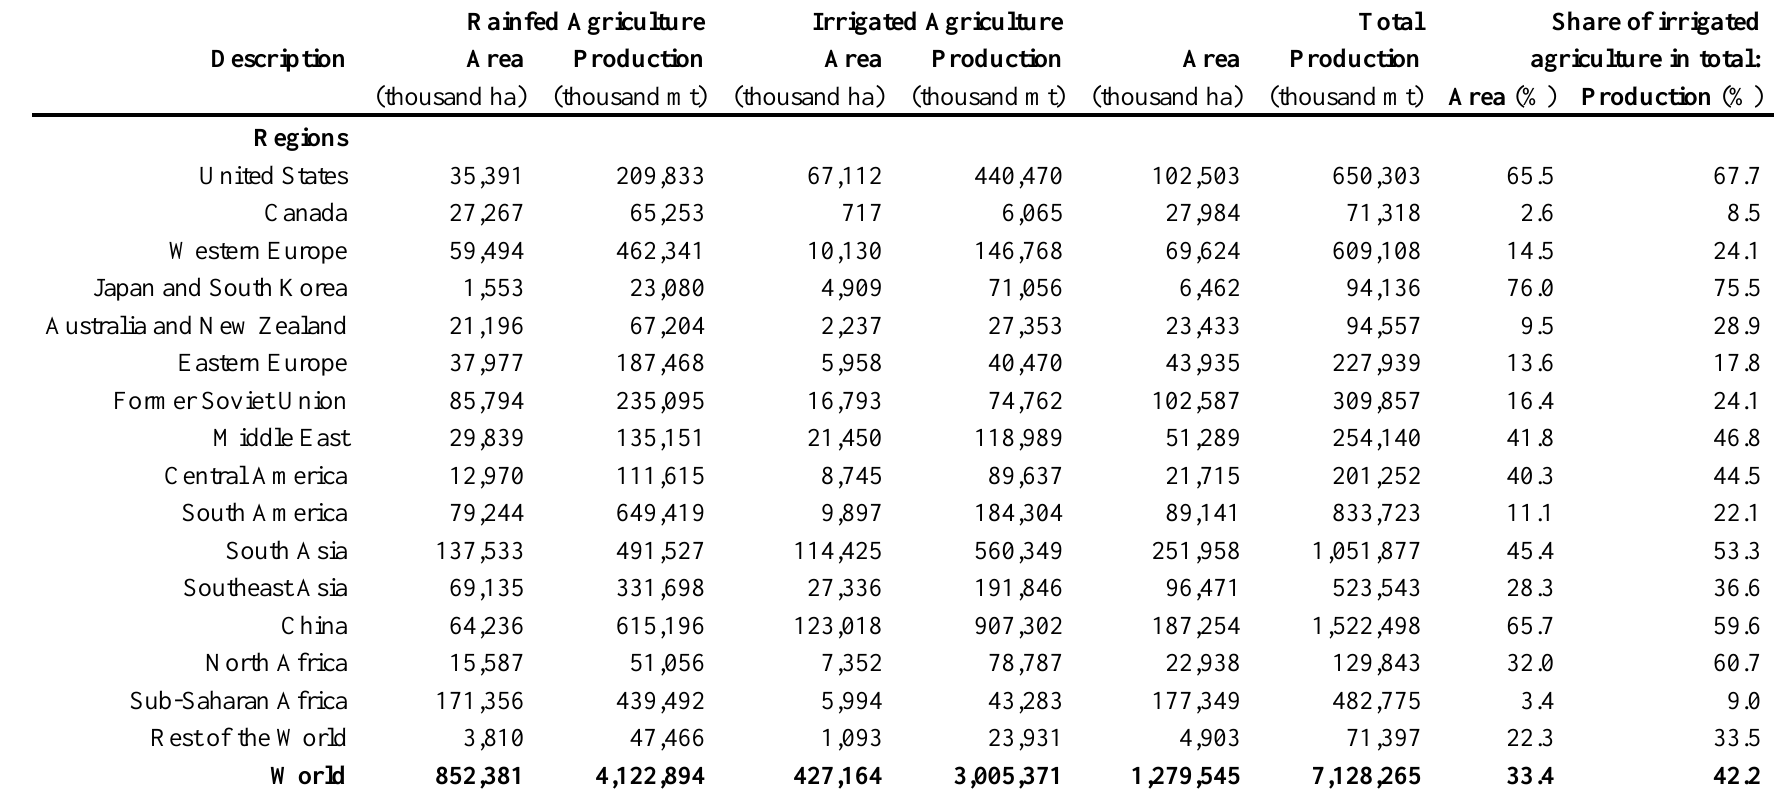
Table B1. 2000 baseline data: Crop harvested area and production by region and crop. Rainfed